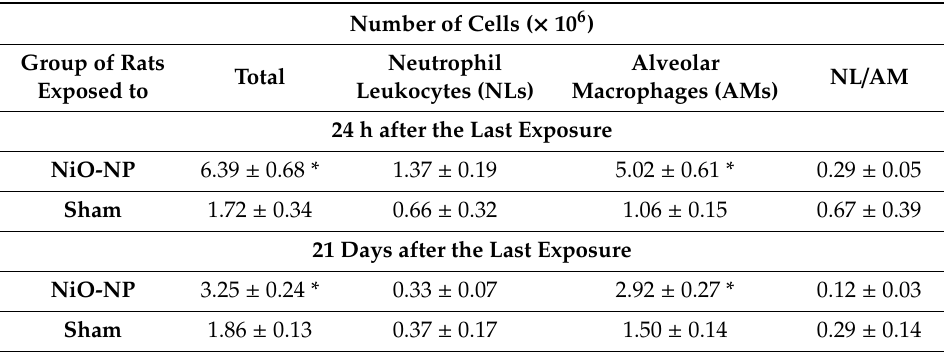
Table 2. Number of cells in the bronchoalveolar lavage fluid (BALF) after 4 h inhalation exposures